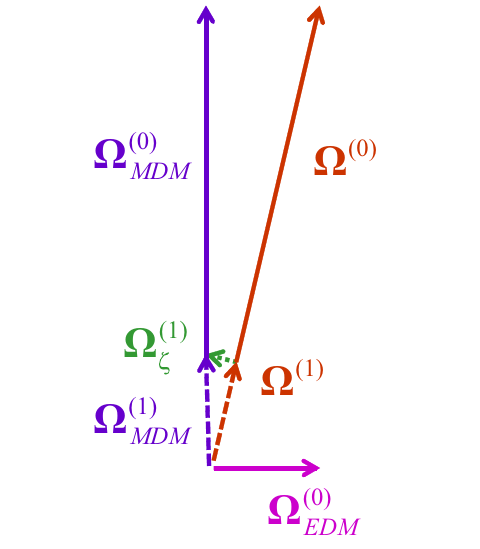
Fig. 3 rf Wien filter. While the resonance action on the EDM vanishes, the resonance effect is ensured by the action of the oscillating fields on the MDM and is defined by the vector (cid:4)